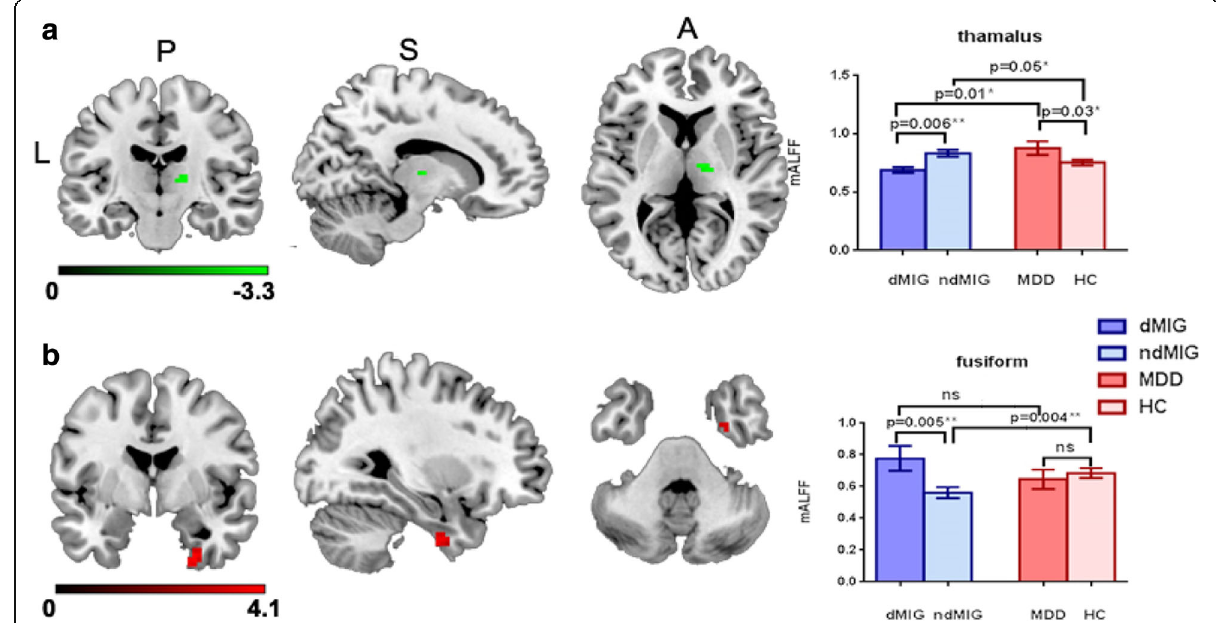
Fig. 2 Significant interaction effects. Significant interaction effects in right thalamus ( a ) and the right fusiform ( b ); * uncorrected, P < 0.05. ** indicated Bonfornni corrected. dMIG migraineurs with depression, ndMIG migraineurs without depression, MDD patients with major depressive disorder and, HC healthy